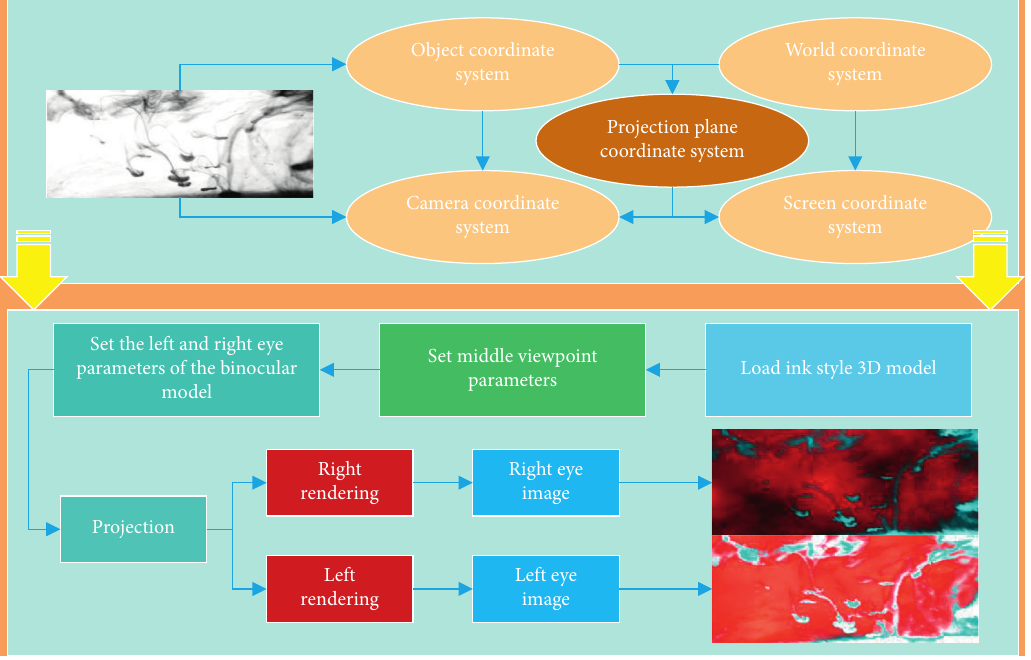
Figure 2: Predictive